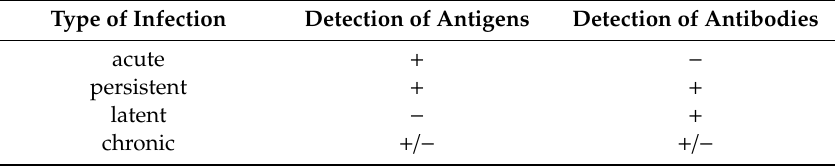
Table 5. Possibility of Antigen / Antibody Detection in Di ff erent Types of Infection [38]. Type of Infection Detection of Antigens Detection of Antibodies acute + − persistent + + latent − + chronic +/ − +/